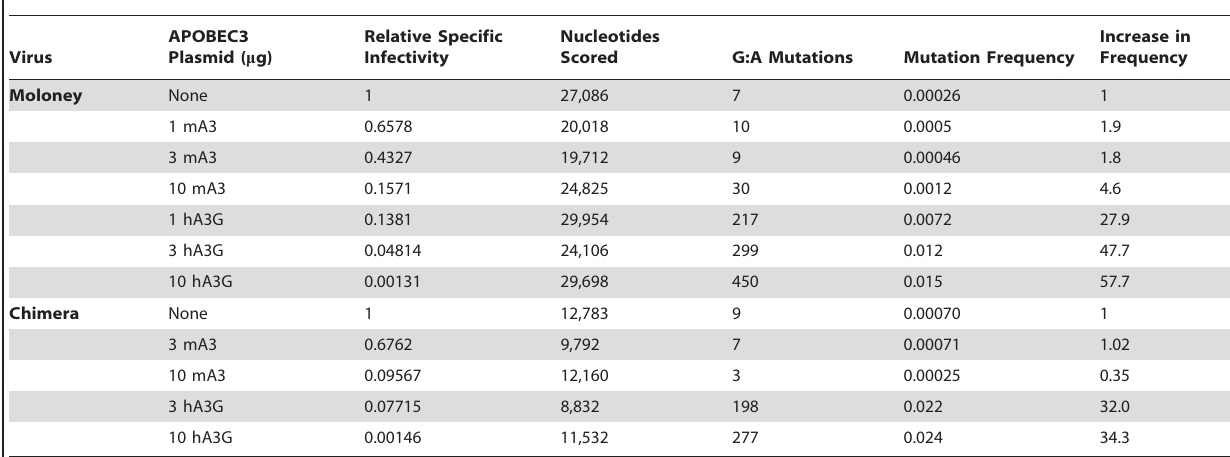
doi:10.1371/journal.pone.0038190.t001